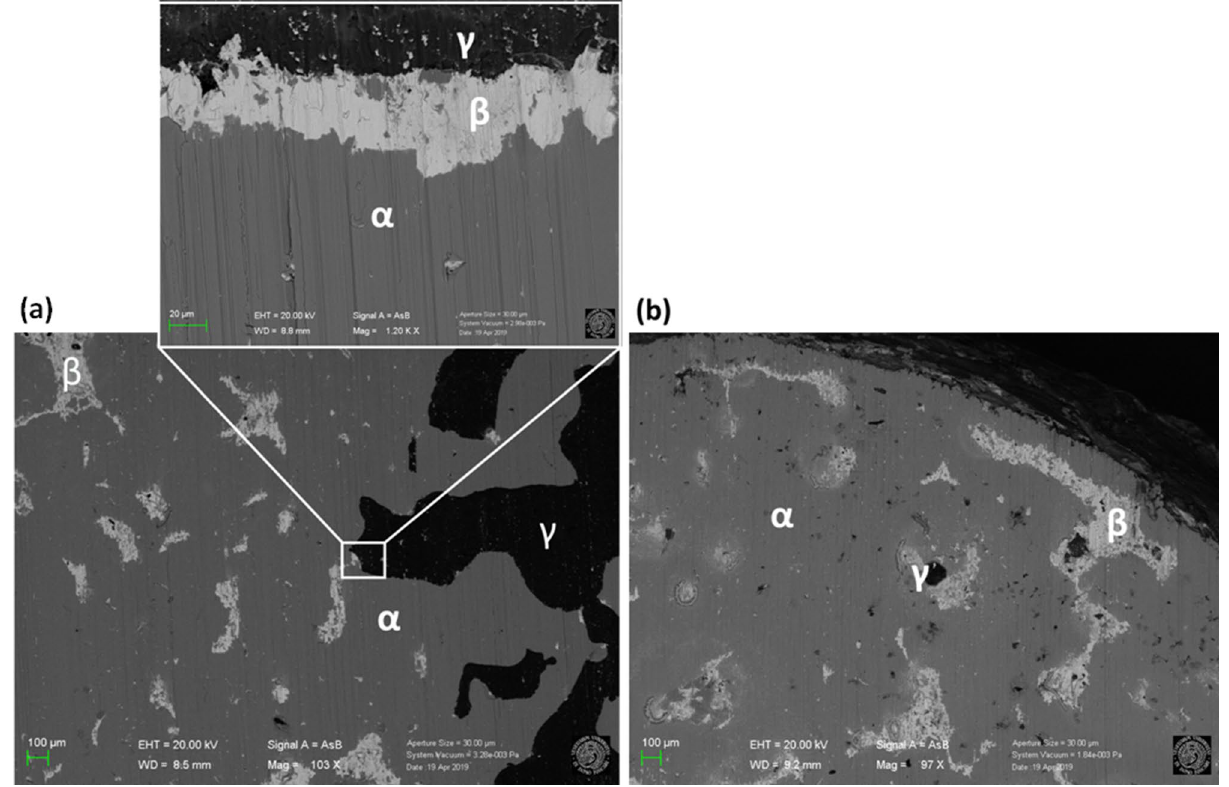
Figure 6. Surface characterisation by FESEM at 20 keV of the bulk matrix of inclusion #2 after sectioning: image of the interface between the three main regions observed with a magnification of 103 × and a zoom-in on the profile of the darker region ( a ). Image of the area next to the sphere perimeter with a magnification of 97 × ( b ). Inset: labels of the different phases identified, respectively the ɑ -phase (light grey) made of a copper- tin alloy, the β-phase (white) consisting of lead oxide and the γ-phase (black) made of glass. (Image: Davide Cristofori, Giulia Moro). Zone Element Z